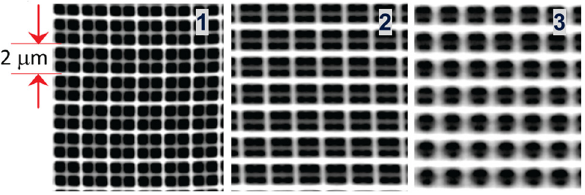
Figure 4: Scanning electron microscopy (SEM) images of the structures made at the same focusing conditions (13 TW/cm 2 ) in SZ2080 ™ pure (1) and doped with 1 wt. % of PI (2 and 3). (1) representsAI case, (2) – AI + 2PPand (3) – 2PP + 1PP. Reprinted with permission from